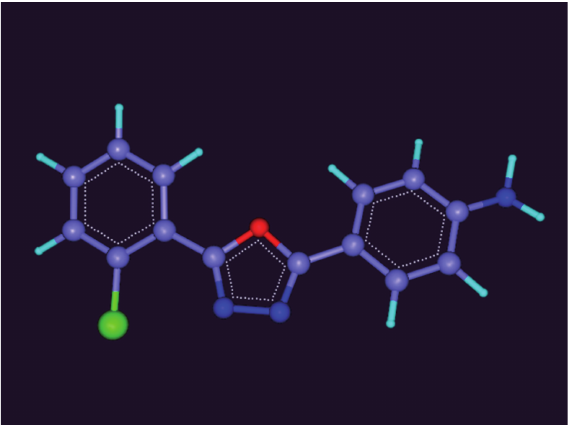
F 2: Reference molecule (compound